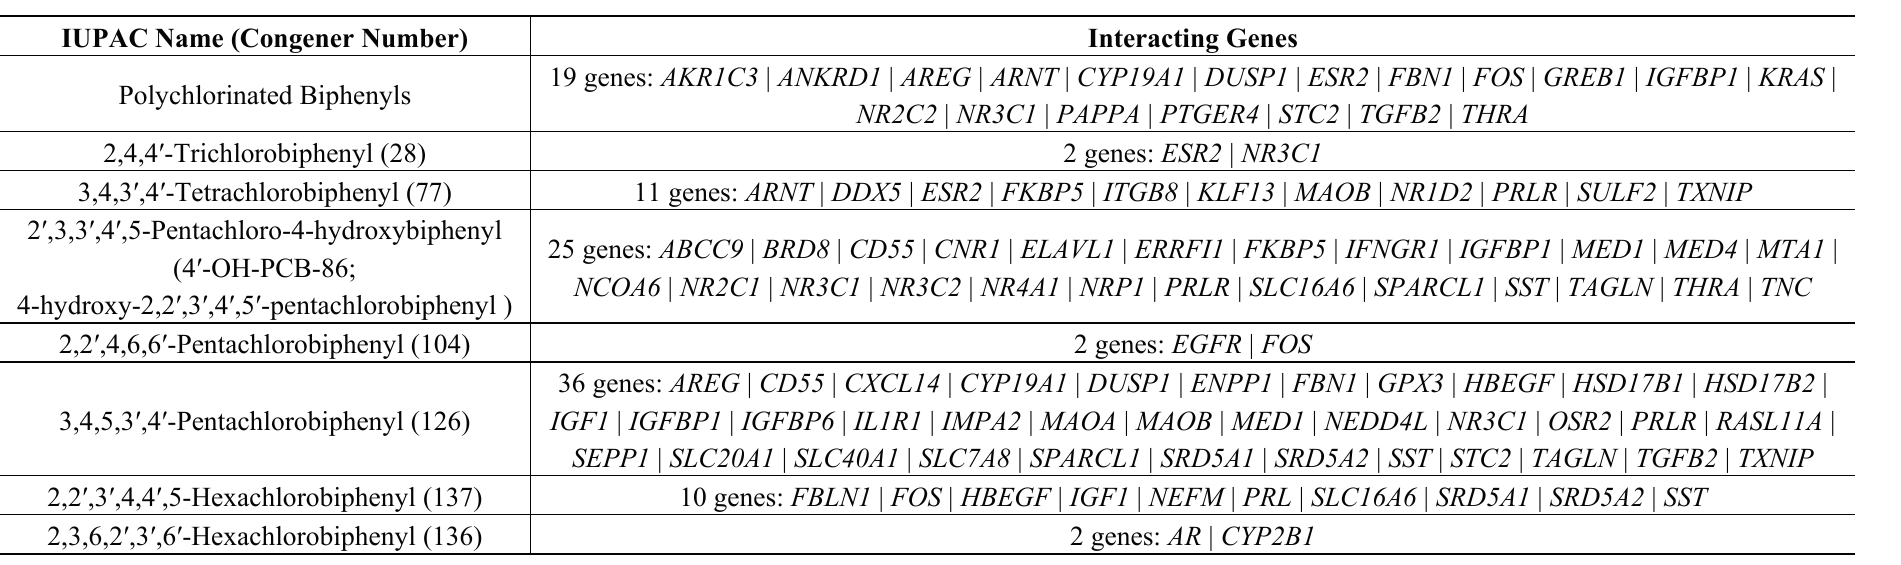
Table 6. Genes interacting with polychlorinated biphenyls in